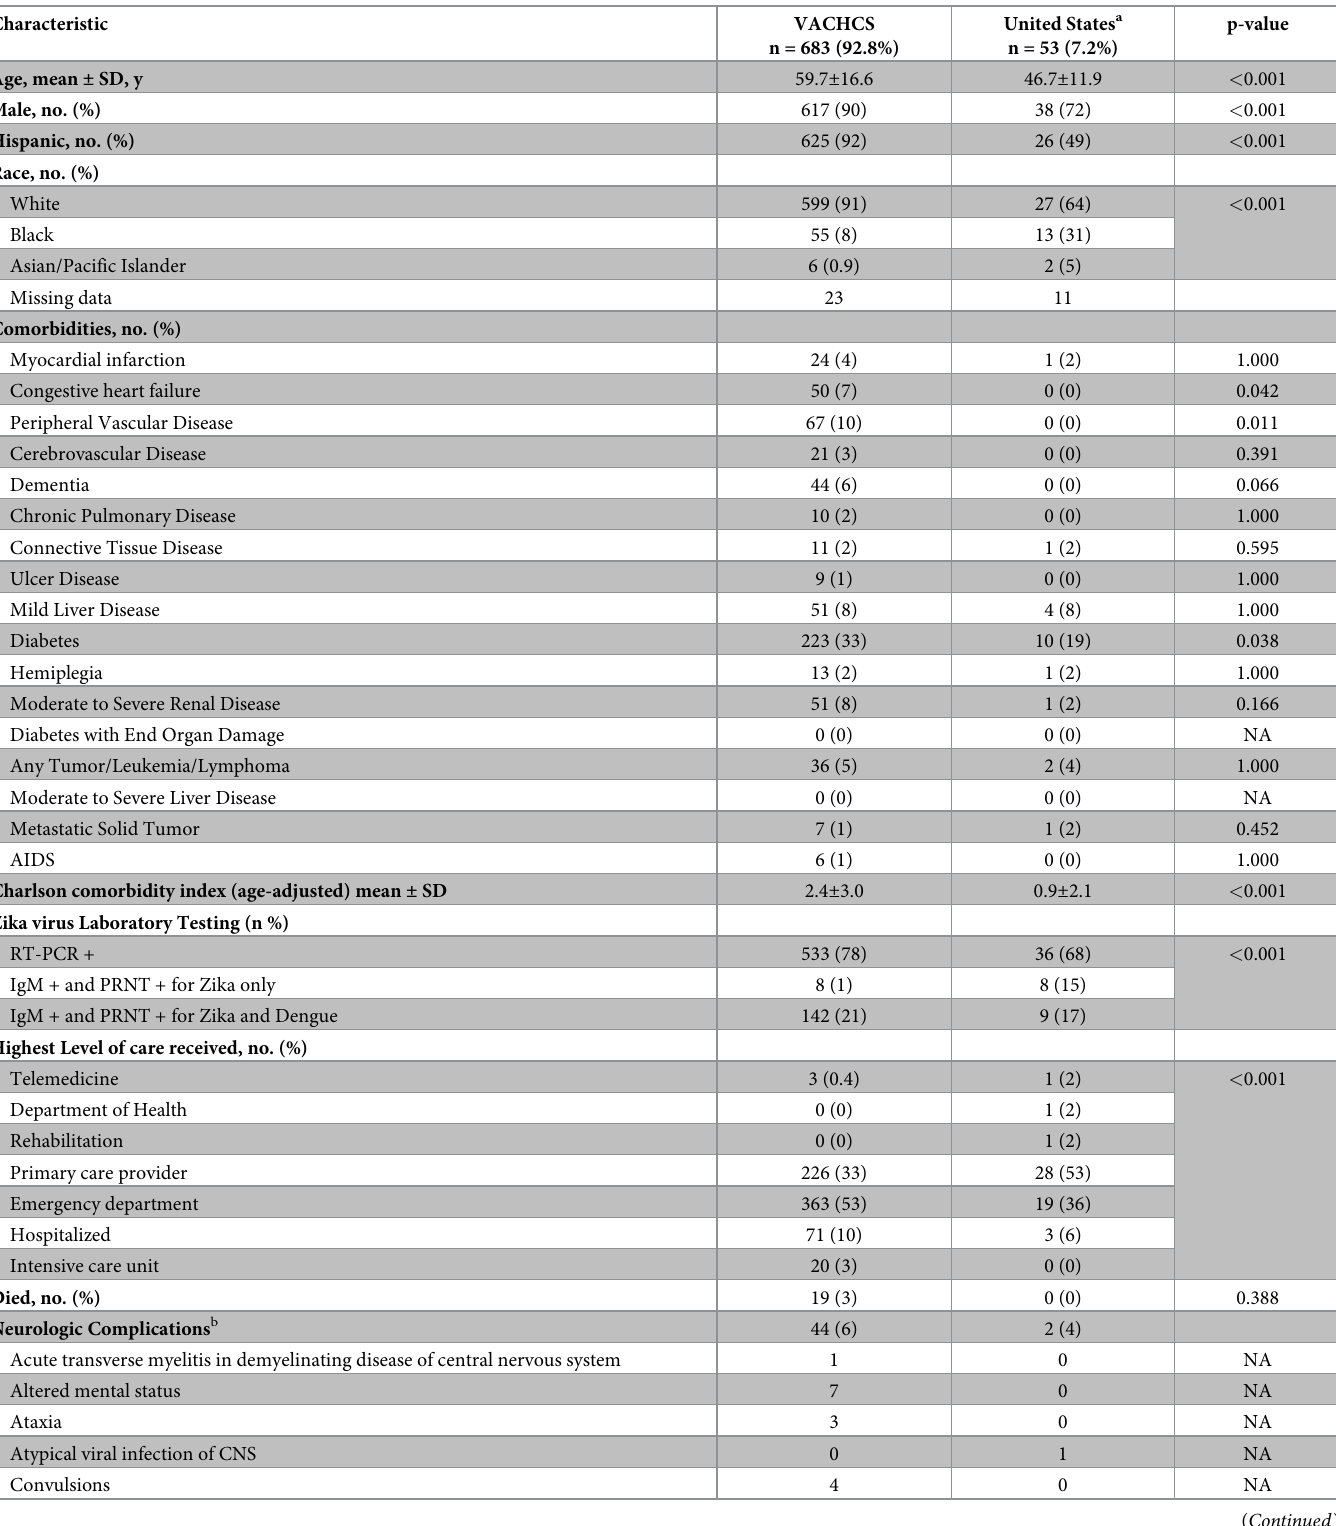
Table 1. Demographics and clinical characteristics of patients with ZIKV infection—Veterans Health Administration, December 2015-October 2016 (n = 736).